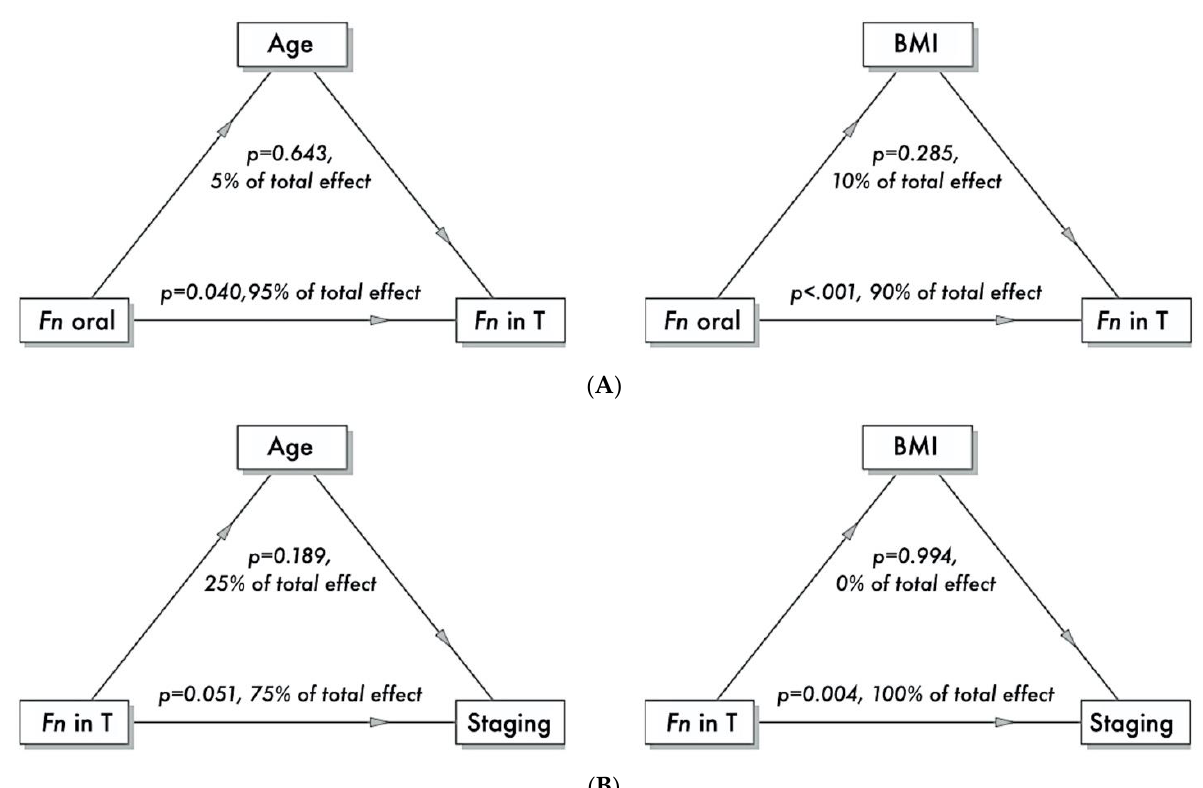
Figure 3. Mediation analysis. Panel ( A ) Quantity of Fn in the oral tissue was the predictor, quantity of Fn in the tumoral tissue the dependent variable and age or BMI the mediators. The analysis revealed the age and BMI exerted only a trivial mediation (5% and 10%, respectively) on the conditional dependence between Fn in the oral and tumoral tissues. Panel ( B ) Quantity of Fn in the tumor tissue (T) was the predictor, staging the dependent variable, and age or BMI the mediators. The analysis revealed that age exerted only a small mediation (25%, even though not significantly), whereas the BMI did not exert any, on the conditional dependence between Fn in the tumoral tissue and cancer staging.